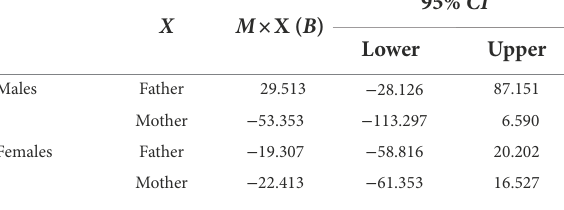
TABLE 8 Moderation model for implicit mate preference, parental education level and urban-rural